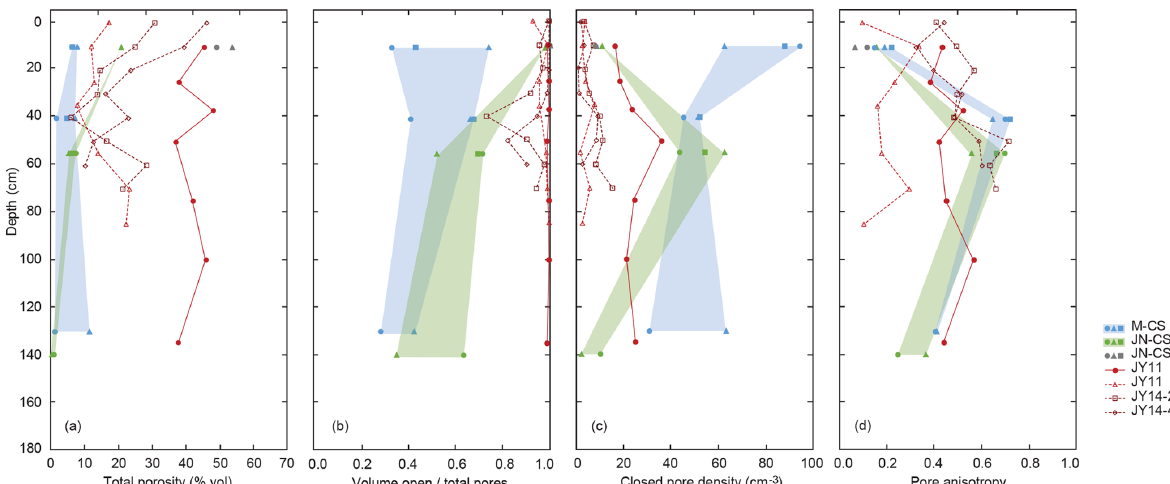
Figure 10. Sea ice internal pore properties calculated from 3-D reconstructions of micro-CT scans of cuts of cores collected in May, June, and July. (a) Total porosity as a percentage of the analyzed volume. (b) Volume of open pores vs. total volume of pores in the analyzed volume. (c) Average spatial density of closed pores in the analyzed volume. (d) Anisotropy of pores in the analyzed volume. Depths indicate the in situ depth within the ice of the top of the volume of interest used for the calculations. Colors indicate sampling month: May (M-CS; blue), June (JN-CS; green), and July (JY11 and JY14 in red and dark red, respectively). Shaded blue and green fields represent the range of values measured in replicate ice horizon samples in May and June, respectively. Closed markers indicate DMP-casted samples; open markers indicate non-casted samples. Values calculated from a volume believed to be representative of a retextured snow layer in the uppermost June samples are represented by gray symbols. For all points, the volume analyzed was a 77.6cm 3 cylinder (diameter = 4 . 97cm, height = 4 . 0cm) selected from a representative portion of the interior of the cut sea ice